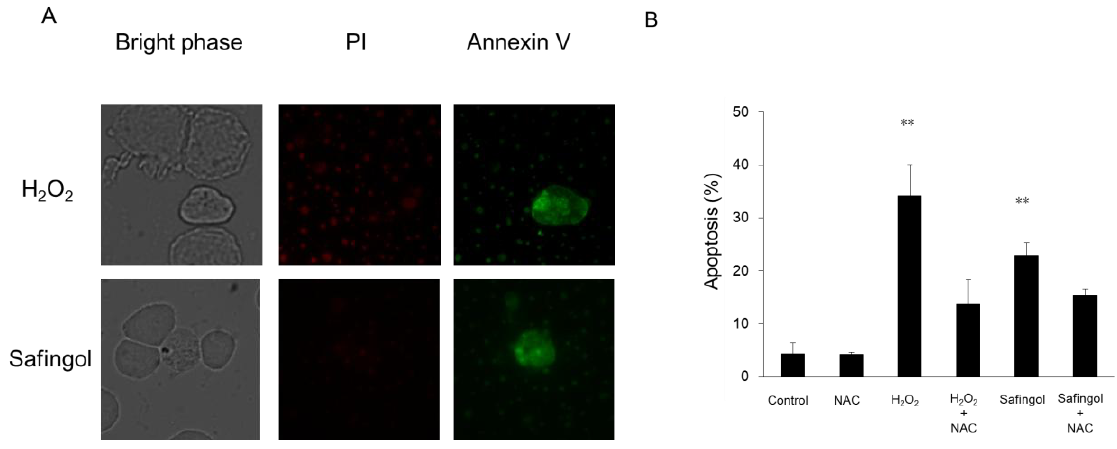
Figure 3. Induction of apoptotic cells death by H with 100 µM H O or 15 µM safingol alone ( A ). Alternatively, they were also treated with 2 2 H O or safingol in the presence of the ROS scavenger NAC for 12 h. Thereafter, the cells 2 2 were stained with annexin V and PI. The percentages of apoptotic cells stained with annexin V alone were calculated ( B ). The data represent the mean ± SD of three determinations. ** p < 0.01 vs. treated group with